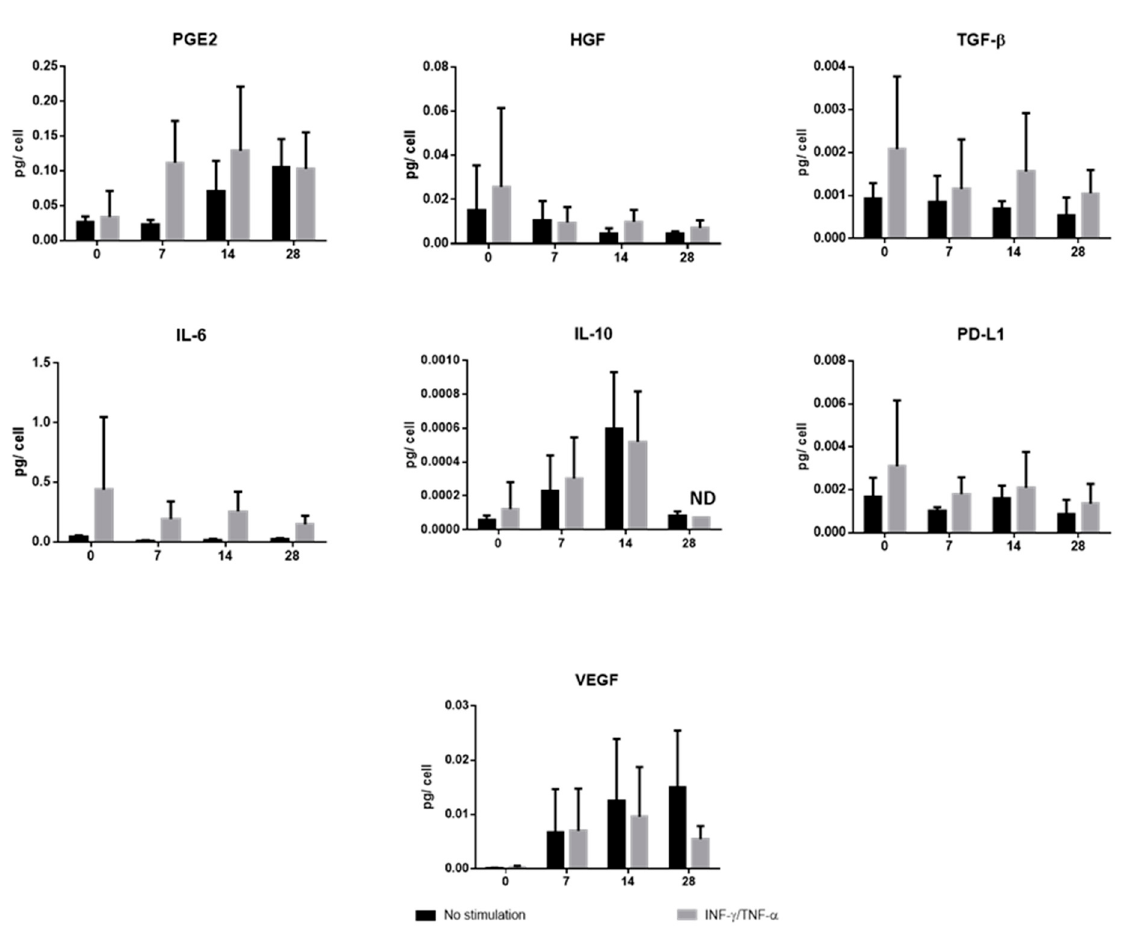
Figure 6. Cytokines (Interleukin 6 (IL-6) and Interleukin 10 (IL-10)), growth factors (hepatocyte growth factor (HGF), transforming growth factor beta 1 (TGF- β 1) and vascular endothelial growth factor (VEGF)) and other molecules (Prostaglandin E2 (PGE2) and soluble PD-L1) secreted by mesenchymal stem/stromal cells (MSCs) on Day 0 (monolayer) and during chondrogenic differentiation (Day 7, 14, and 28) in two conditions (with stimulation (grey color) or without stimulation (black color). Results were obtained with Enzyme-Linked Immunosorbent Assay (ELISA) and were calculated in picogram per cell. Data are expressed as mean ± SD ( N = 3 independent cords minimum); ND means non-detectable for the other 2 cords.